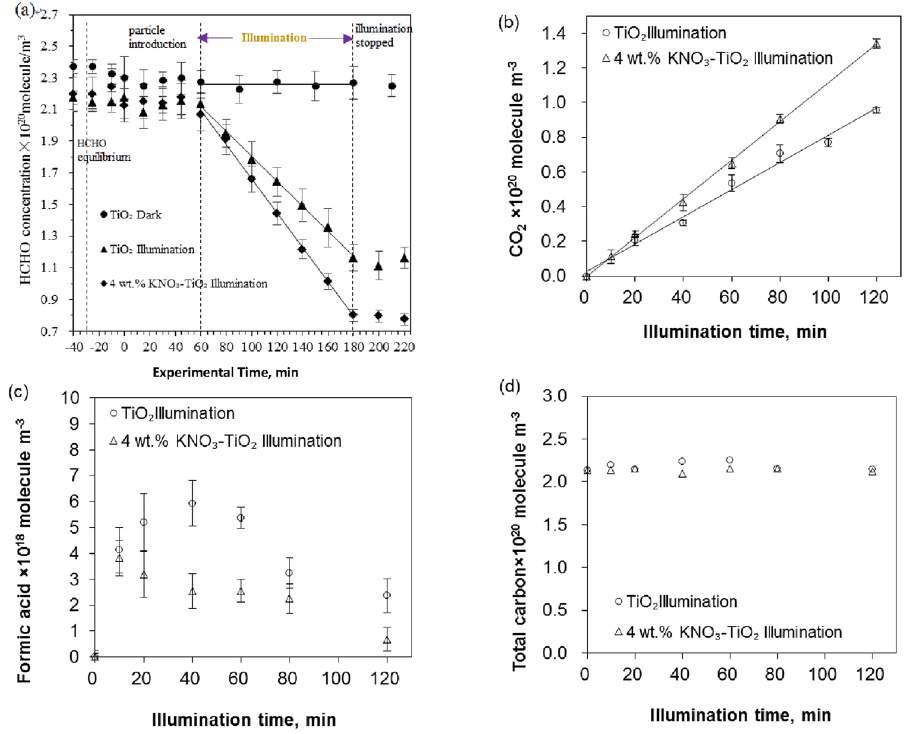
Figure 1. Kinetic curves of reactant and products. ( a ) Concentrations of formaldehyde. ( b ) Concentrations of CO 2 . ( c ) Concentrations of formic acid. ( d ) Concentrations of total carbon. “TiO 2 dark” is TiO 2 aerosol in dark condition, “TiO 2 Illumination” is TiO 2 aerosol in illuminated condition, “4 wt.% KNO 3 -TiO 2 illumination” is 4 wt.% KNO 3 coated TiO 2 aerosol in illuminated condition. The RH inside the Chamber is